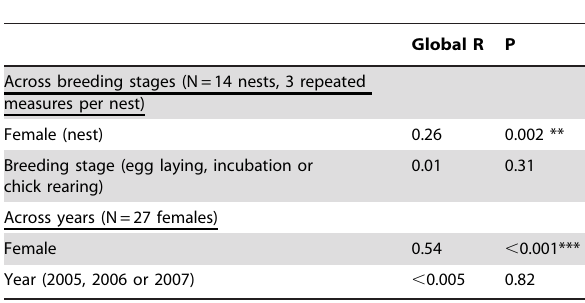
Table 1. Individual repeatability in aromatic plant species composition of blue tit nests, both across breeding stages and across years, as tested by analyses of similarity (Anosim, see Materials and